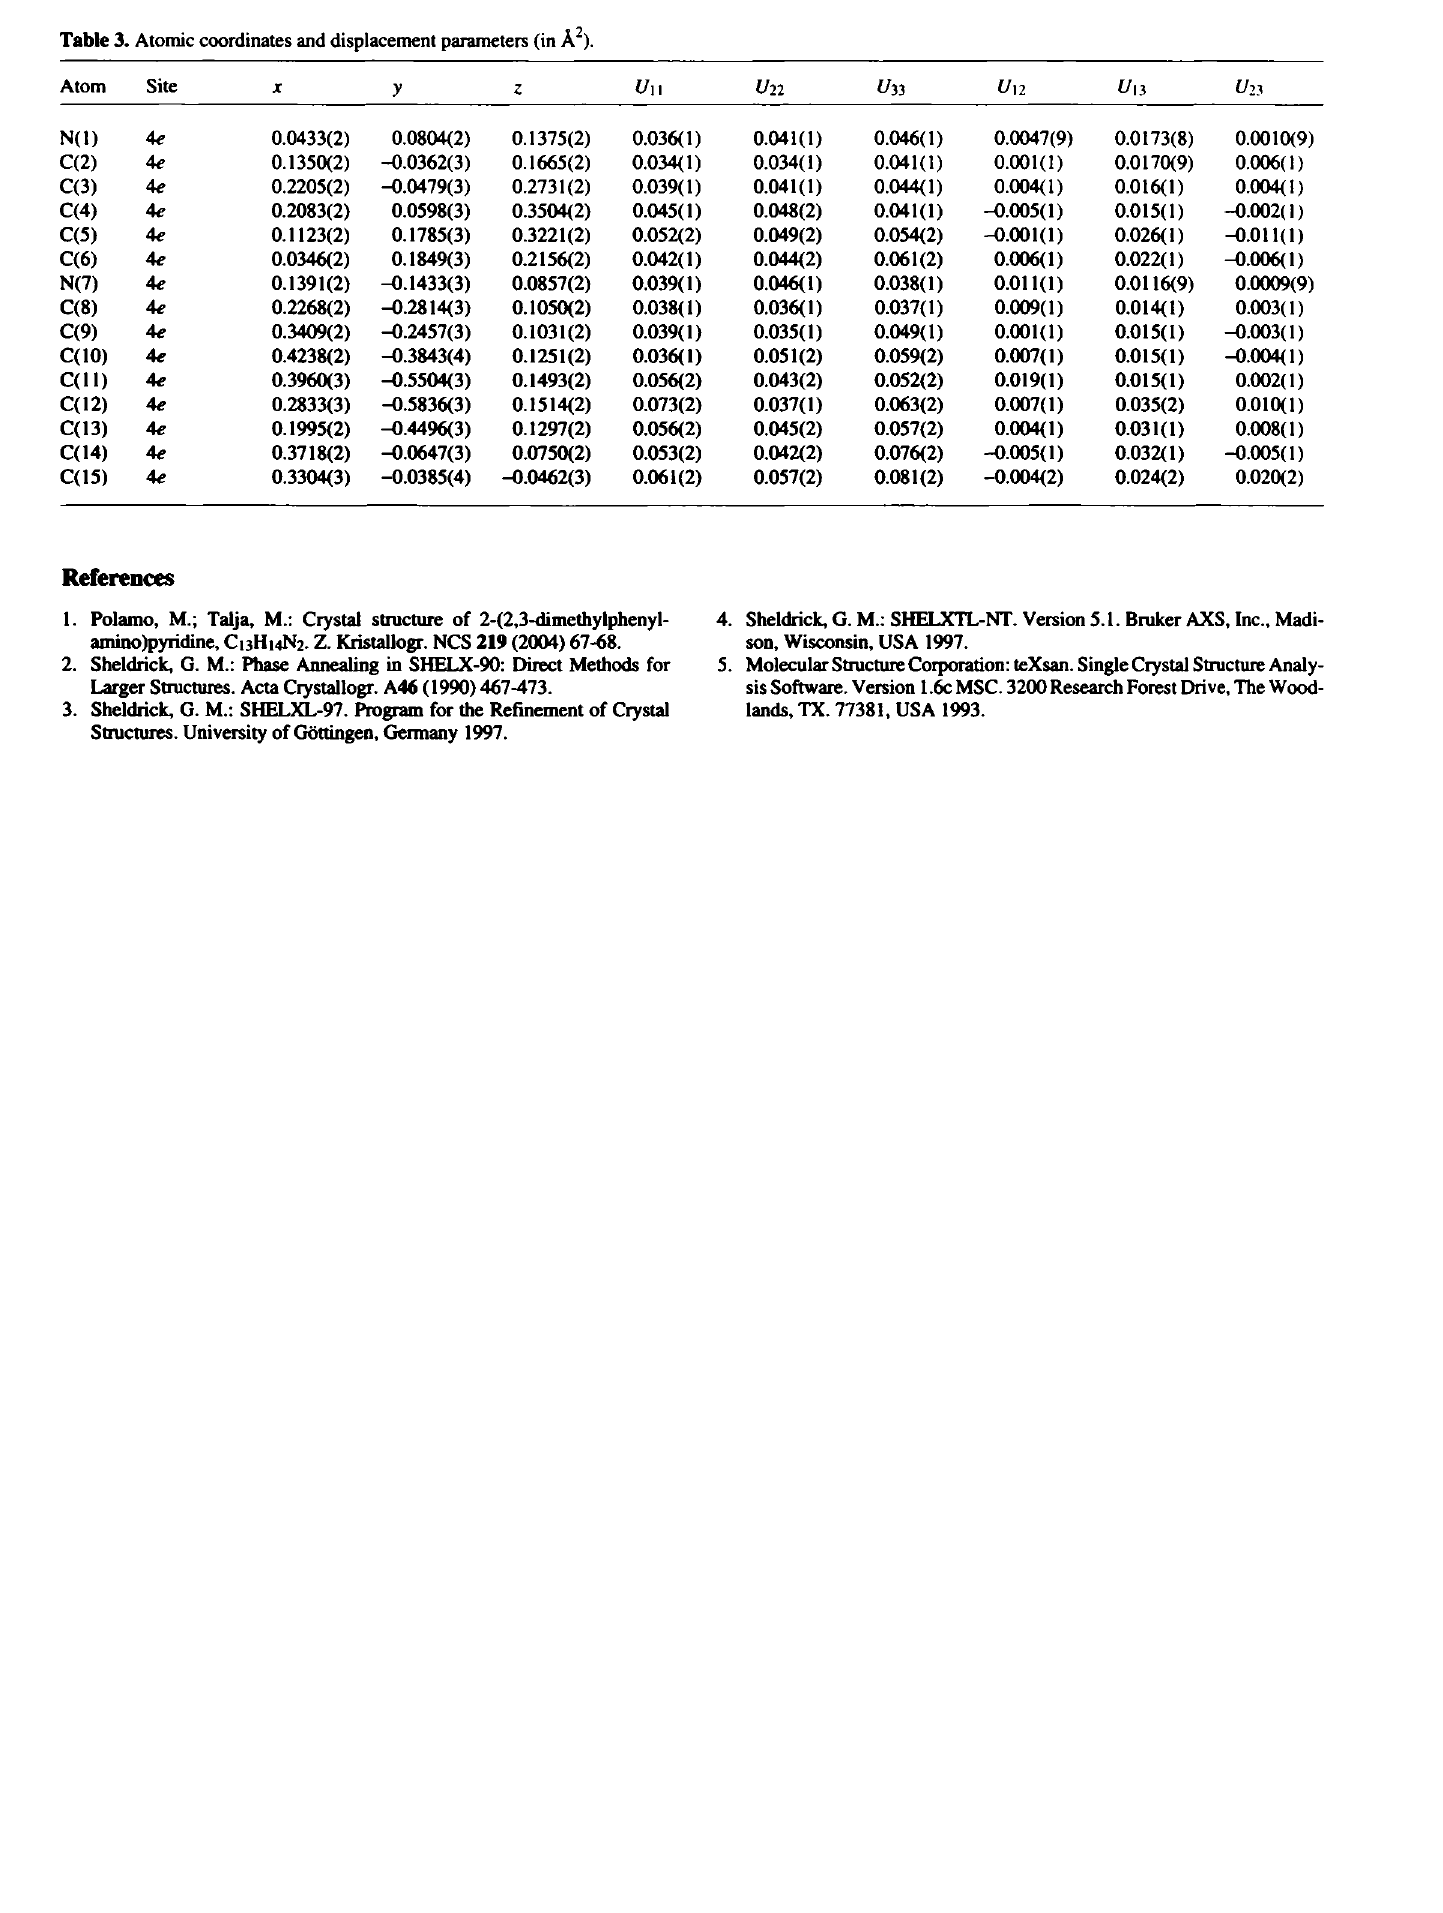
Table 3. Atomic coordinates and displacement parameters (in Â 2